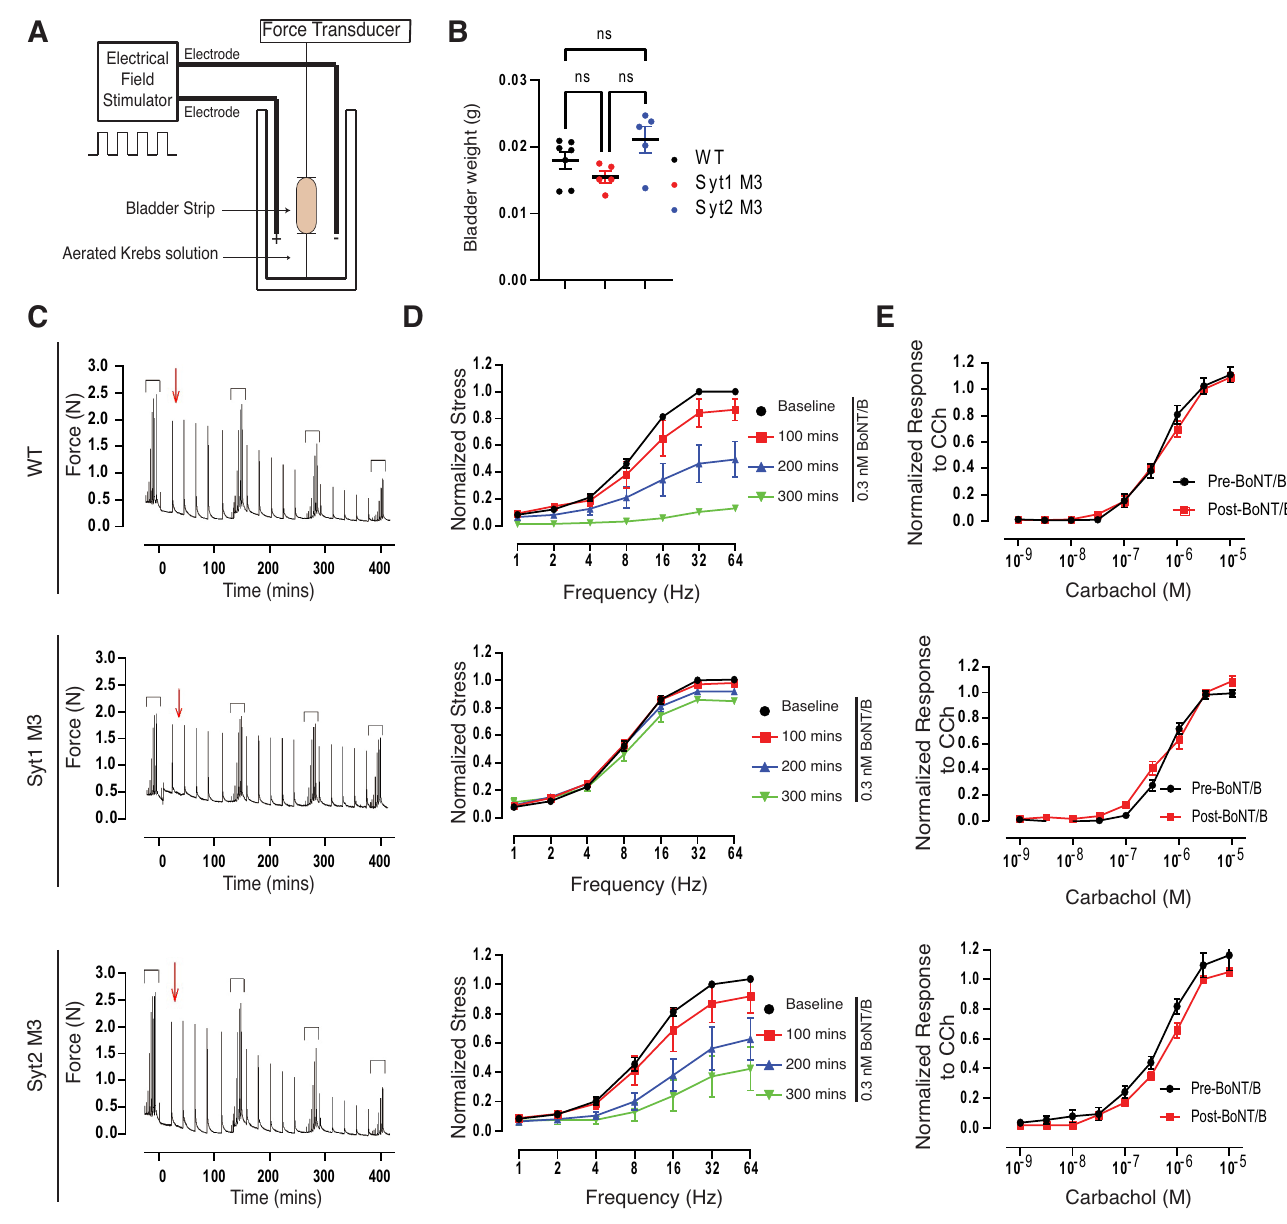
Fig 5. Syt1 M3 bladder strips are less sensitive to BoNT/B in e x vivo bladder contraction assays. A. Schematic diagram of ex vivo bladder strip contraction assay. Bladder strips were immersed in aerated Krebs solution. Exogenous pharmacologic agents (i.e., carbachol, BoNT/B) were added directly to the solution. Trains of voltage delivered over a range of frequencies were generated by the electrical field stimulator to trigger bladder contraction, which is detected and measured by the force transducer. B. Bladder weights across WT and KI mice were similar prior to ex vivo contraction assay. ns = not significant (ANOVA). C-D. The nerve- evoked contraction forces of WT (n = 3), Syt1 M3 (n = 5), and Syt2 M3 (n = 4) bladder strips were recorded, with the representative force trace shown in C. A set of frequency-dependent stimulations (enclosed by brackets above tracing) were delivered every 100 min. After a baseline frequency-response, evoked responses at constant frequency (16 Hz) were produced every 15 min. BoNT/B (0.3 nM) was administered at red arrow. The time dependent effects of BoNT/B on nerve evoked responses are shown in frequency-response curves that were plotted in 100 min intervals, shown in D. Incubation with BoNT/B reduced contractions of WT and Syt2 M3 bladders, but did not affect Syt1 M3 bladders. � p < 0.05, repeated measures ANOVA. E. Carbachol induces direct muscle contraction independent of neurotransmission. Carbachol does-response curves were generated at the beginning and end of the experiment as a control showing that bladder strips maintained their viability and contractility after incubation with BoNT/B for 300 min. p > 0.05, RM